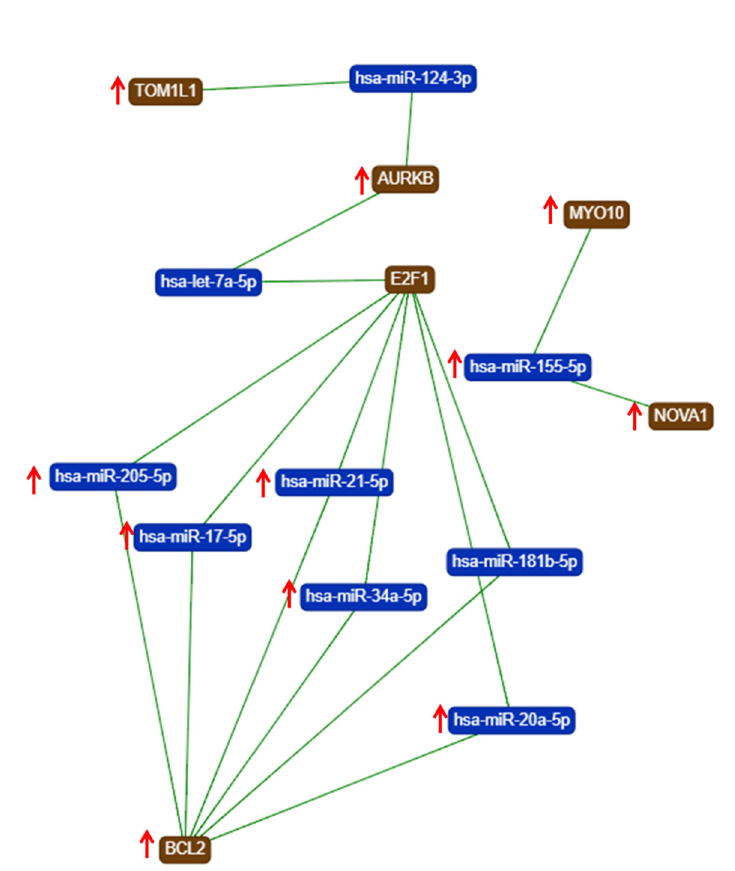
Figure 8. An mRNA–miRNA iinteraction map for each of the hub genes with prognostic values for CC, generated using miRtargelink (Available online: https://ccb-web.cs.uni-saarland.de/mirtargetlink/). Only those strong interactions are herein presented ( ↑ overexpressed transcript).